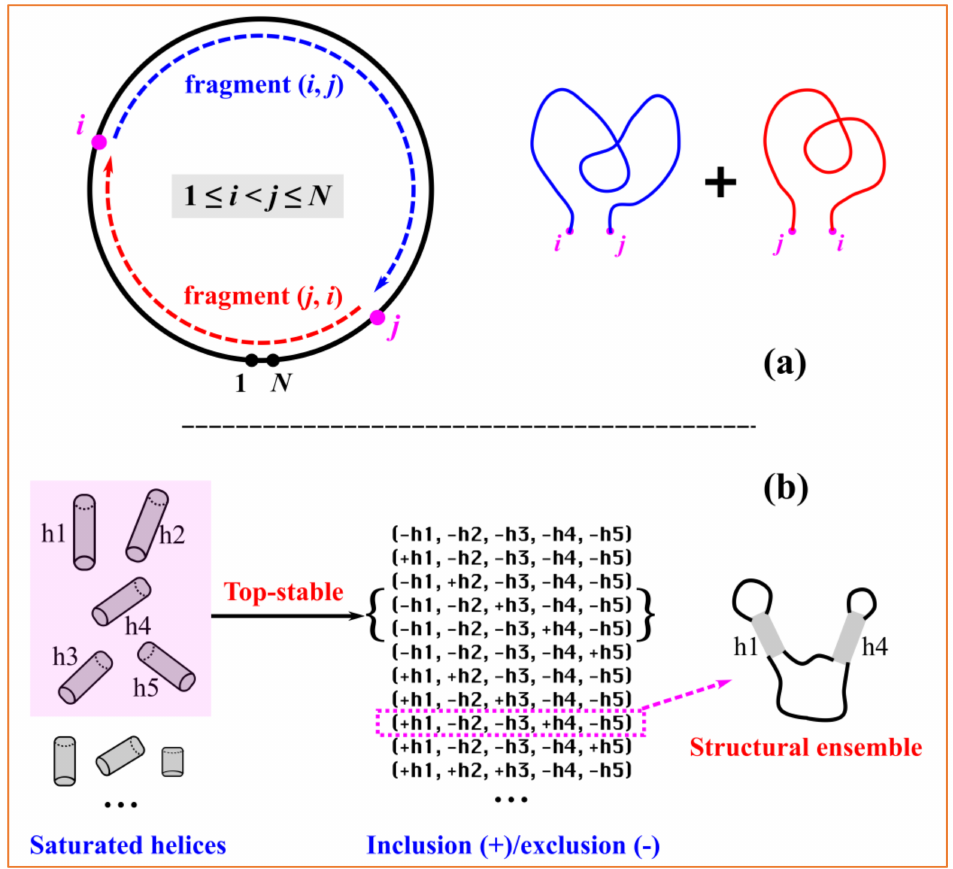
Figure 5. Algorithm of the cRNAsp12 model. ( a ) Two nucleotides are selected to divide a circular RNA sequence into two linear fragments. Secondary structures and folding stabilities of a circRNA are calculated by the additivity assumption characteristic of recursive algorithms. Here, i and j are the nucleotide numbering within the range of (1, N ). ( b ) By selecting top-stable helices, the entire folding landscape is divided into distinct partitions. Each partition defines a structural ensemble featured by the inclusion/exclusion of